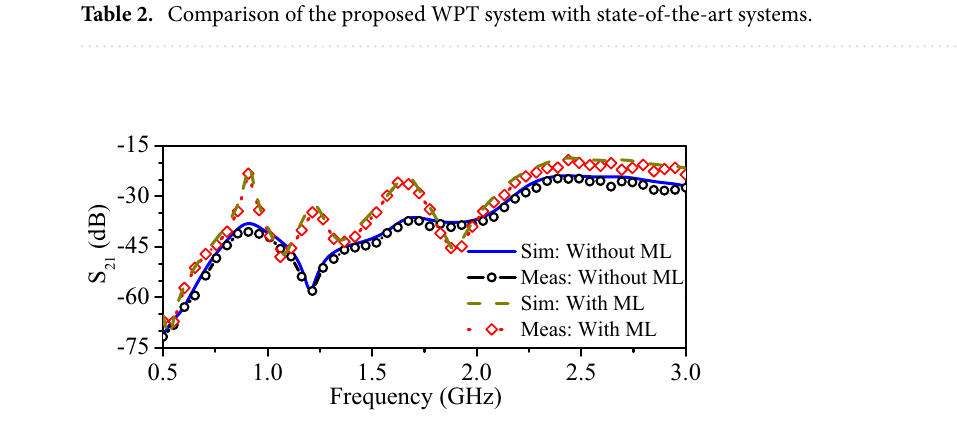
Figure 15. Transmission coefficient ( S 21 ) of the WPT system with and without the matching layer (ML).